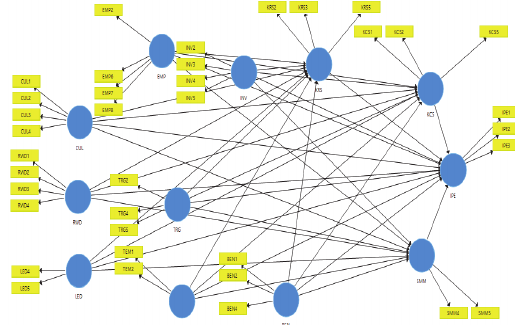
Fig. 2. Data Analysis Results